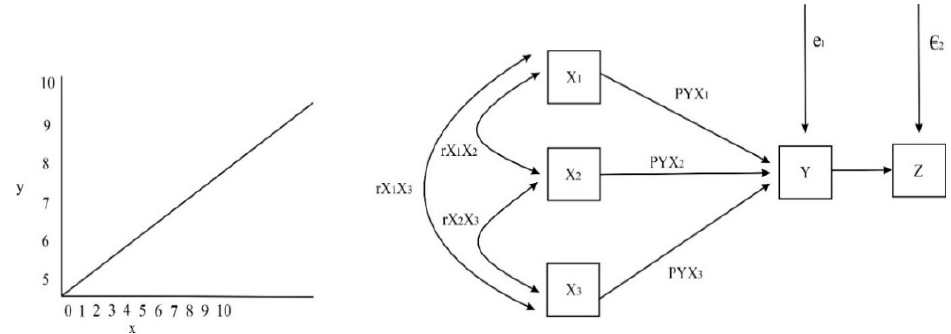
Figure 3. Linearity and Path Chart .